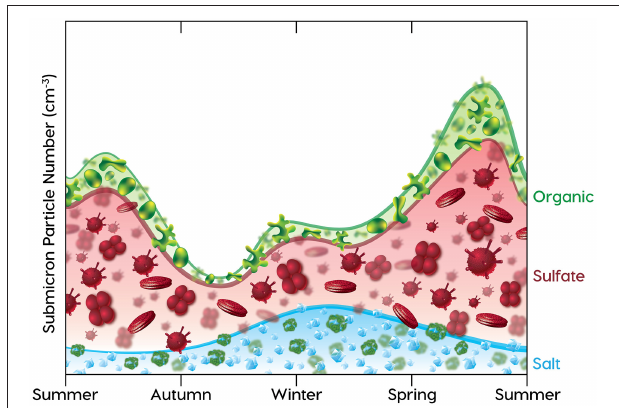
FIGURE 2 | Stylized annual submicron aerosol number concentration cycle, beginning on left in midsummer and ending in early summer, showing contributions to number from sea spray salt (blue line), DMS-derived sulfate (red line), and ocean-derived organic (green line) components. The components are shown proportional to number, but should not be interpreted as externally-mixed particle populations. Blue line with NaCl cubes = ocean sea spray particles, scaled to interpolated monthly seasonal wind speed (U102) estimated from figure 1b of Young (1999). Red line with Prymnesiophyte (from NAAMES data) and Coccolithophore (from Bidle, 2015) images = sulfate-containing particle number concentrations scaled to monthly DMS emissions, estimated from figure 6 of Lana et al. (2011). Green line with organic component images ( Hawkins and Russell, 2010) = organic-containing particle number concentrations, tracked to sulfate particle mass assuming similar seasonal productivity but 25% lower mass contribution. Relative contributions of each component to particle number concentrations are calculated from mass concentrations [for ranges reported in Table 1 of Sanchez et al. (2018)] by dividing by the cubes of modal diameters of 0.4 µ m for sea spray particles, 0.2 µ m for sulfate particles, and 0.3 µ m for organic particles [using diameter ranges reported by Quinn et al. (2017) and Sanchez et al.